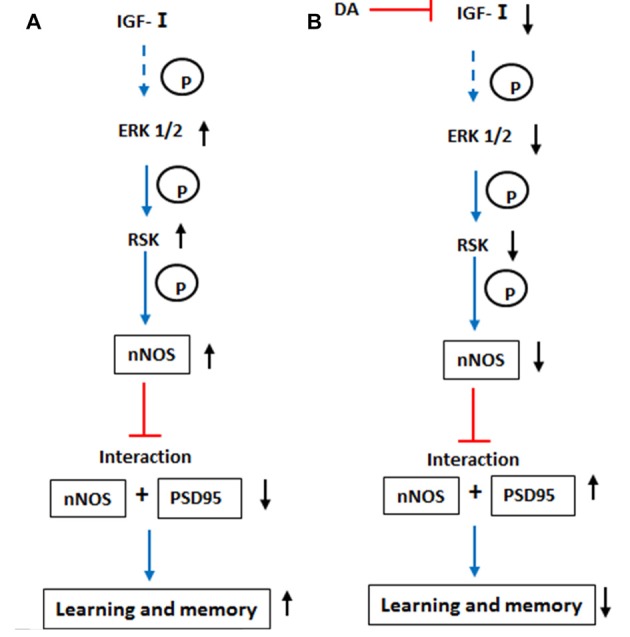
Homeostasis of IGF-I-mediated cognitive signaling in neurons. (A) IGF-I initiates its effects through the activation of ERK1/2. Once activated, phosphorylated tyrosine residues on ERK1/2 recruit downstream RSK, which phosphorylates nNOS and disrupts the interaction of nNOS with PSD95, leading to trigger the learning and memory. (B) DA antagonizes the effect of the IGF-I signaling pathway.